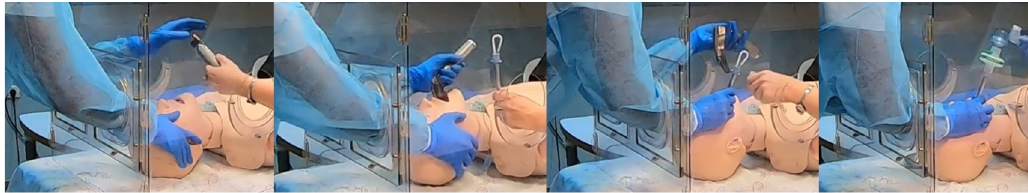
Fig 2. Endotracheal intubation using the barrier